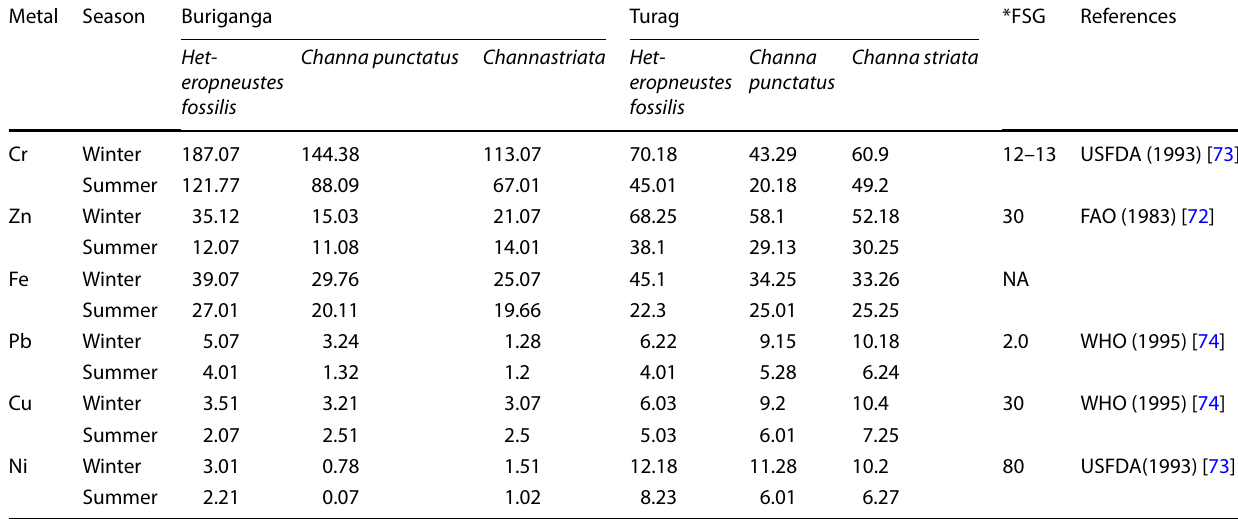
* Food safety guidelines, NA →